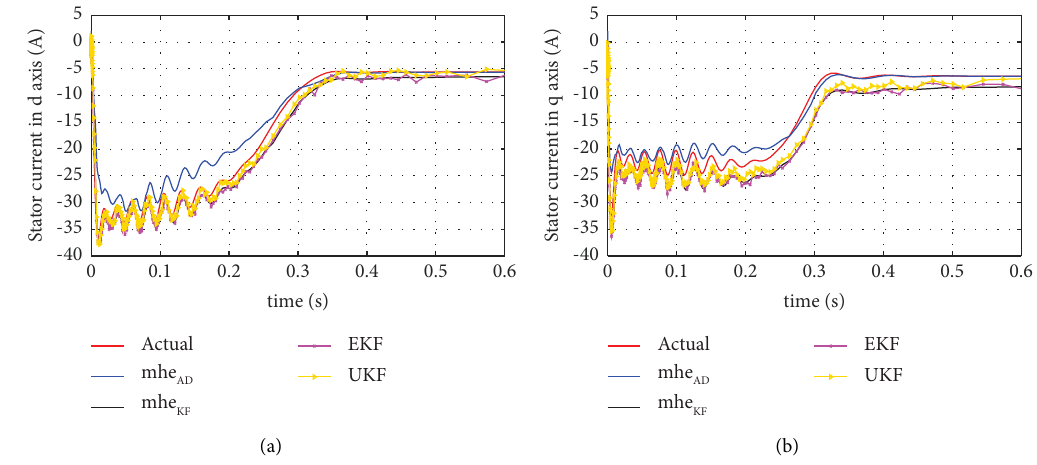
Figure 1: (a) Estimation of stator current in d axis. (b) Estimation of stator current in q axis.